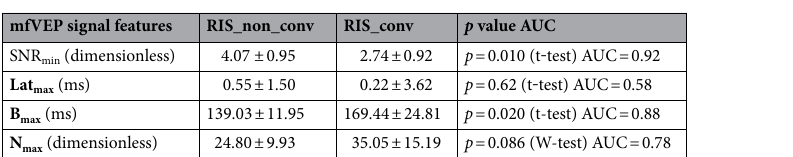
Table 2. Comparison of the variables obtained between the two